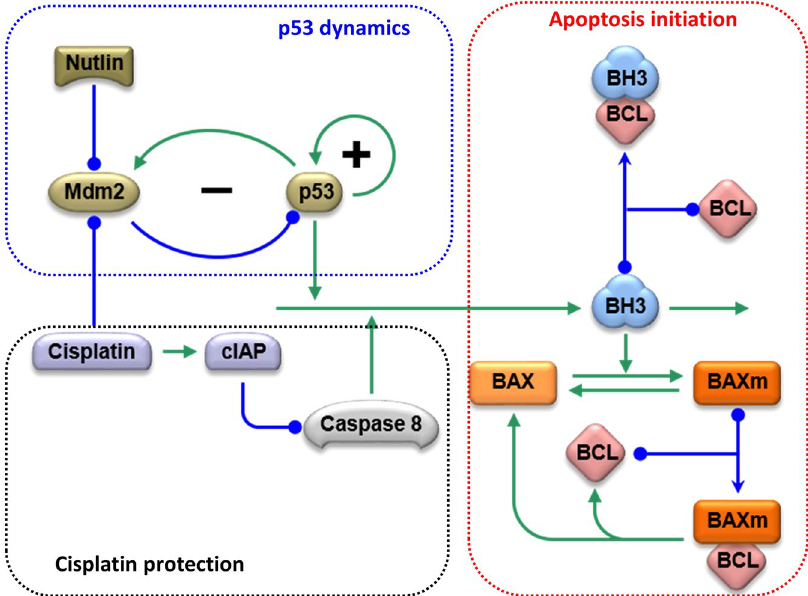
Figure 1. The molecular interactions in the current representative model. Nodes of different shapes represent the model components; arrows indicate activation; lines and curves with solid circle heads indicate repression. The model consists of three functional modules: p53 signaling, cisplatin signaling, and the control of BAX activation. In the p53 signaling module, p53 is controlled by one positive feedback and one Mdm2 mediated negative feedback. In the module of cisplatin signaling, cisplatin activates an incoherent feedforward loop. In one branch, cisplatin activates p53 to promote apoptosis; in the other branch, cisplatin activates CIAP to inhibit Caspase8, thus inhibiting apoptosis. In the BAX activation module, BH3 promotes the transformation of BAX from the inactive, cytoplasmic form, to the activated mitochondrial form. BAXm is inactivated from the BAXm monomer as well as the BAXm:BCL